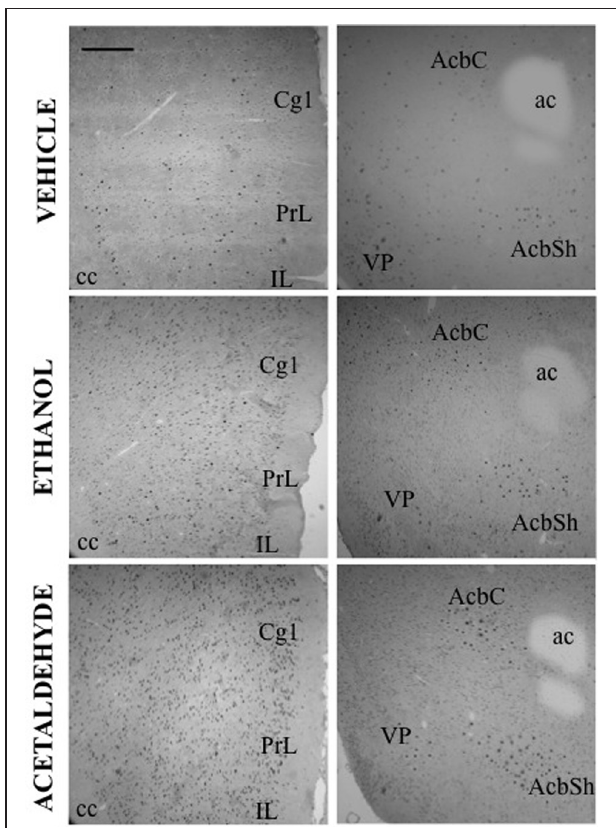
FIGURE 4 | c-Fos induction after ICV administration of vehicle, ethanol (2.8 µ moles) and acetaldehyde (2.8 µ moles). Low power images (10 × ) showing PFC (left column) and Acb (right column). Scale bar =